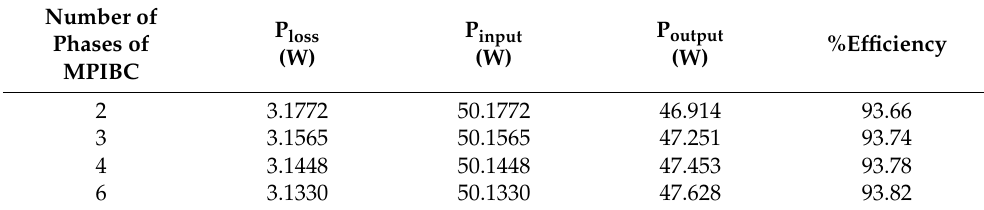
Table 7. Total power loss and efficiency values of MPIBC (input voltage: 20 V).